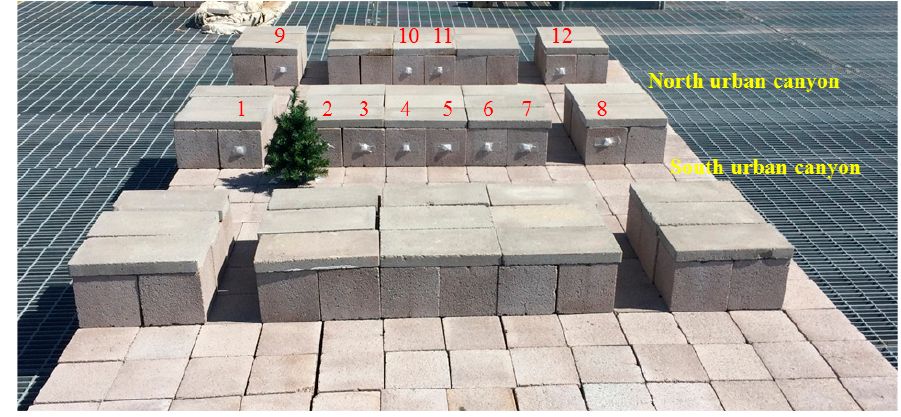
Figure 4. The digital photo of iButton logger locations.